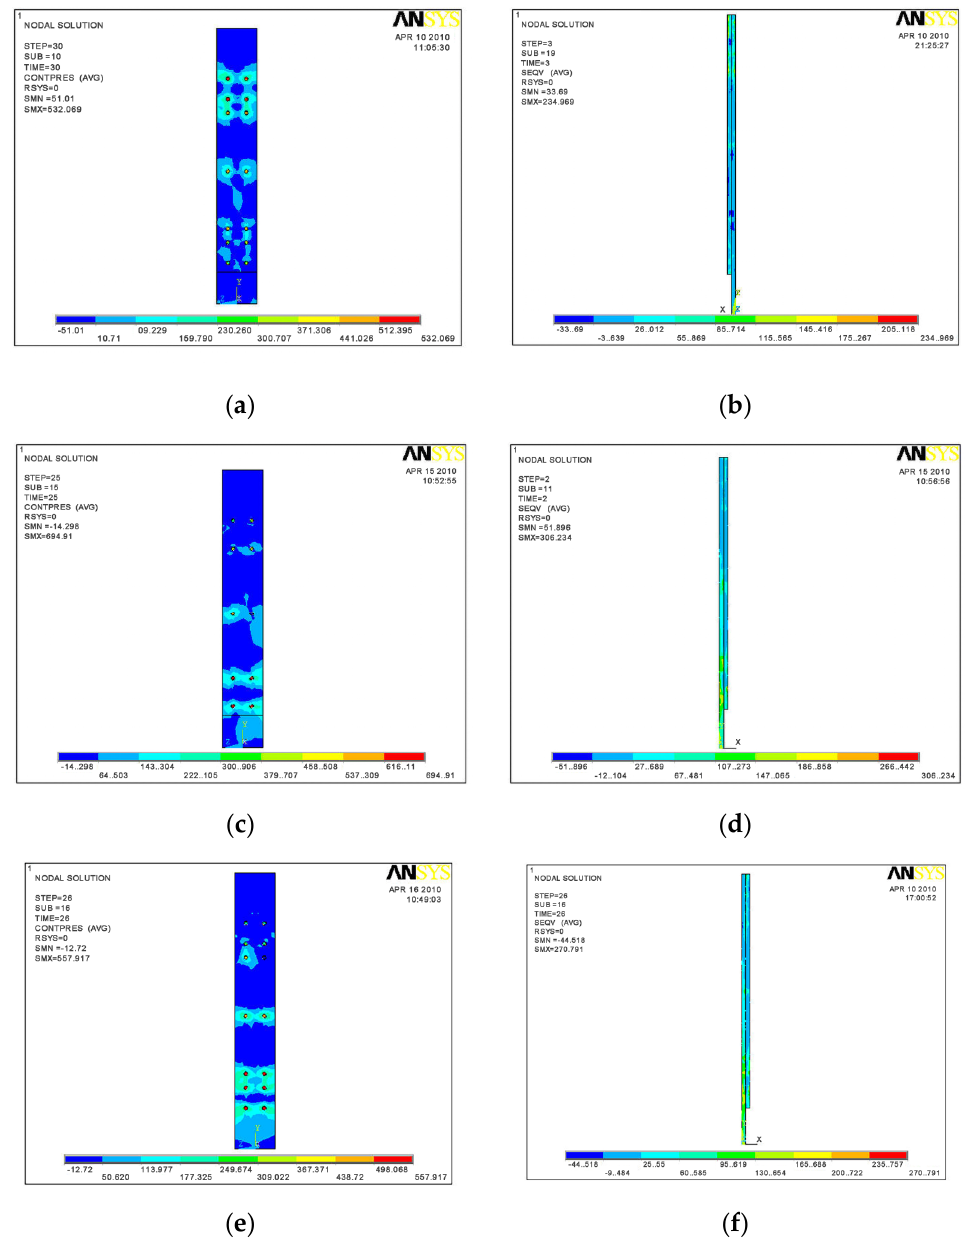
Figure 17. End-plate stress diagrams when specimen failed. ( a ) Contact surface stress of specimen SV1; ( b ) Stress of specimen SV1; ( c ) The contact surface stress of specimen SV2; ( d ) Stress of specimen SV2; ( e ) Contact surface stress of specimen SV3; ( f ) Stress of specimen SV3.